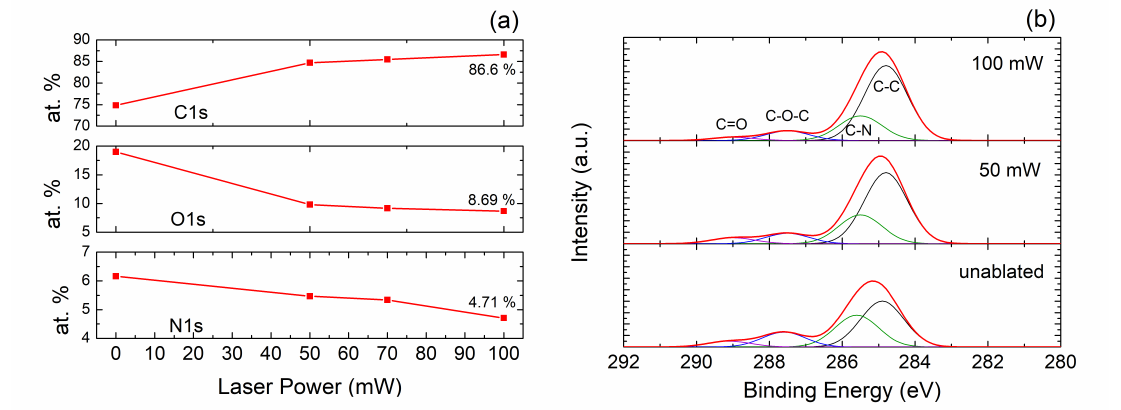
Figure 5. ( a ) atomic percentage of carbon, oxygen and nitrogen in the laser-ablated area as a function of the laser power; ( b ) comparison of the C1s peaks (black: C − C, green: C − N, blue: C − O − C, purple: C = O) from the XPS spectrum of the laser-ablated Kapton R (cid:13) surface using different laser powers (scanned area: 300 × 700 µ m 2 , pass energy: 40 eV, sampling depth: 10 nm, step: 1